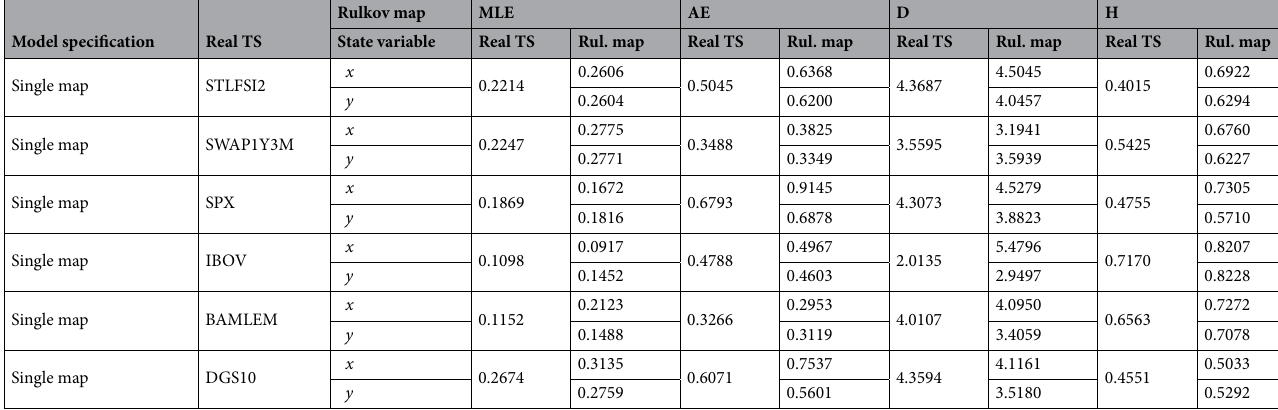
Table 5. Chaotic descriptors Maximal Lyapunov Exponent MLE, Correlation Dimension D, Hurst exponent H of financial time series TS (all figures refer to differenced/detrendized